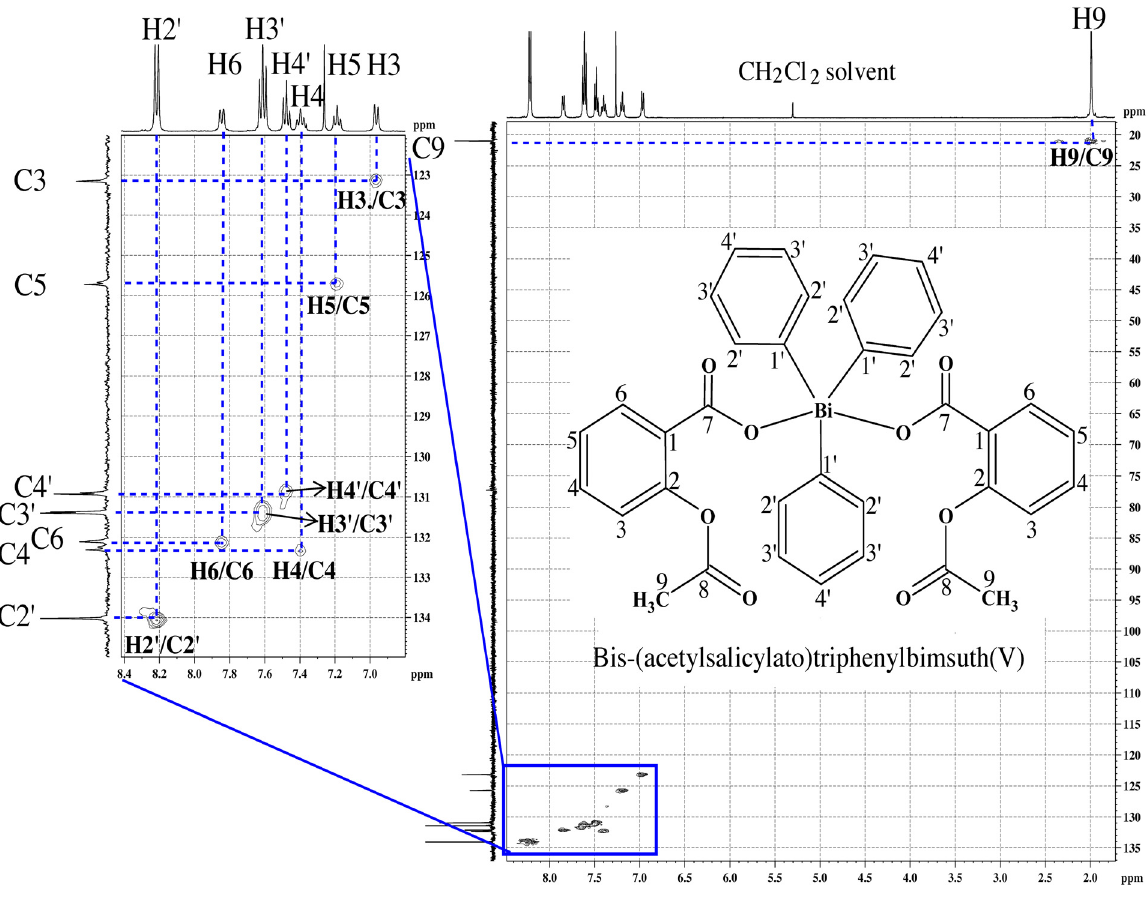
Figure 2. 2D NMR HMQC spectrum of bis -(acetoylsalicylato)triphenylbismuth(V)— complex 3, in CDCl at 27 3